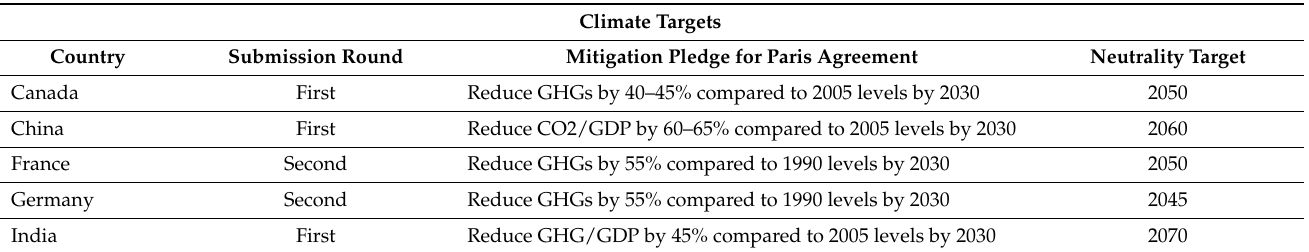
Table 6. Climate mitigation pledge for Paris Accords and neutrality target for selected countries. Climate